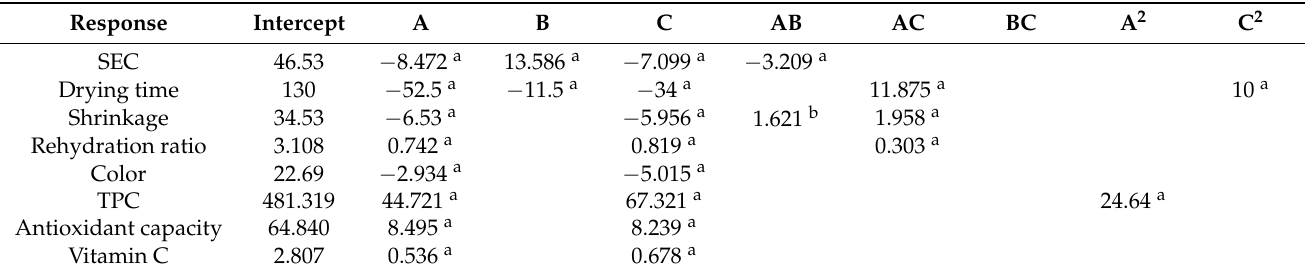
Table 14. Coefficients of the model fitted to the regression equation of response variables (A, air temperature, B, air velocity, and C, IR